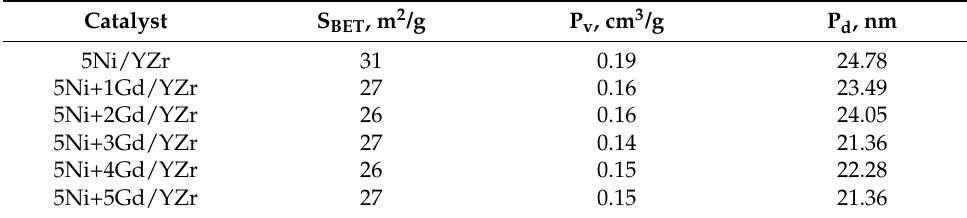
Figure 1. Nitrogen physisorption isotherms of the fresh catalysts. Table 1. Textural properties (S BET , P v , and P d ) of the fresh